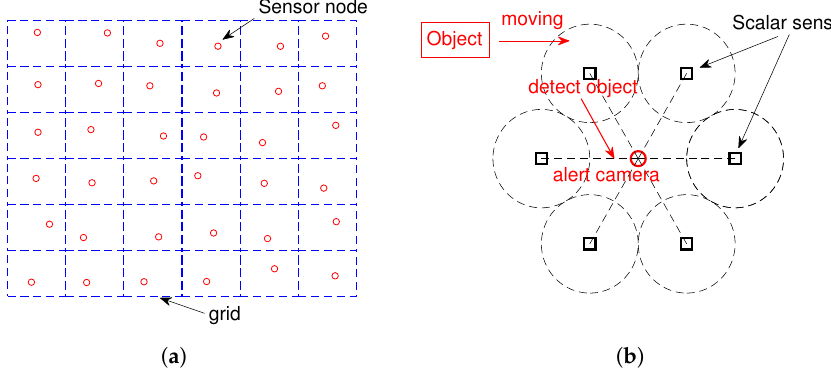
Figure 1. Topology and workflow of wireless multimedia sensor networks: ( a ) topology of the networks; ( b ) workflow of the